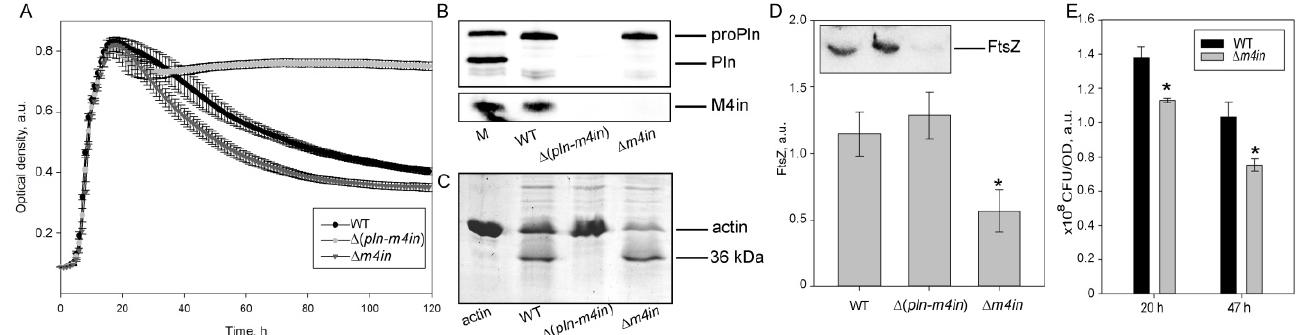
Figure 2. The FtsZ cleavage by protealysin in bacteria. ( A ). Growth curves of S. proteamaculans variants. Values are expressed as a mean of three repetitions ± S.D. (error bars). A difference was considered significant at the * p < 0.05 level. ( B ). Western blot detection of the expression of pln and m4in genes in S. proteamaculans . M—marker containing purified mature protealysin (Pln), protealysin precursor (proPln), and emfourin (M4in). WT, ∆ (pln-m4in) and ∆ m4in lanes were loaded with samples prepared from equal amounts of bacterial biomass. ( C ). Cleavage of actin by extracts of S. proteamaculans variants at 68 h of growth. ( D ). The number of FtsZ (estimated by Western blotting) in the same number of bacteria (determined by OD 600 ) at 16 h of growth. Values are expressed as mean of three repetitions ± S.D. (error bars). A difference was considered significant at the * p < 0.05 level. The insert shows a representative blot. An analysis of three technical replicates is presented. WT—wild-type S. proteamaculans ; ∆ (pln-m4in) —mutant S. proteamaculans with in-frame deletion of both genes of the protealysin operon; ∆ m4in —mutant S. proteamaculans with in-frame deletion of emfourin gene. ( E ). The number of bacteria (CFU) in the bacterial suspensions at 20 and 47 h of growth normalized to the OD600 is shown in the